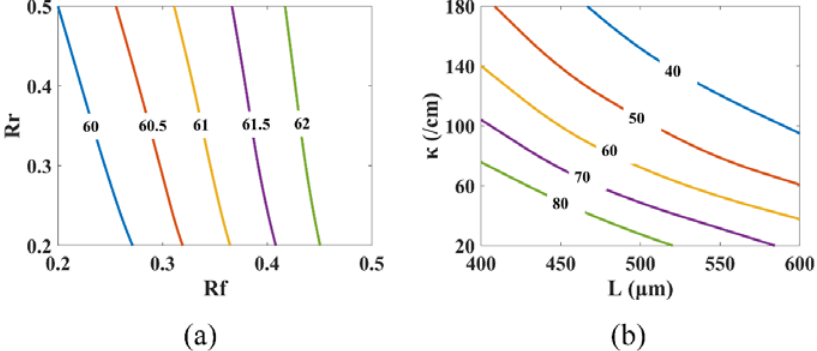
Figure 3. The PPR frequency dependence on parameters with P bias = 12 mW: ( a ) PPR frequency vs. R f and R r with L = 450 µ m and κ = 100/cm; ( b ) PPR frequency vs. L and κ with R f = R r = 0.2.